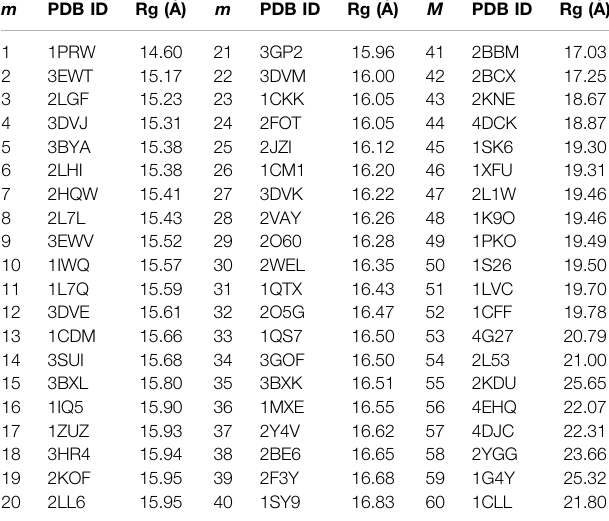
TABLE 1 | The PDB IDs of the 60 non-redundant CaM memory structures for the AWSEM model and the Rg of the CaM. In the case of CaM complexes, only the coordinates of CaM were used for memory. m is the index for the memories. m PDB